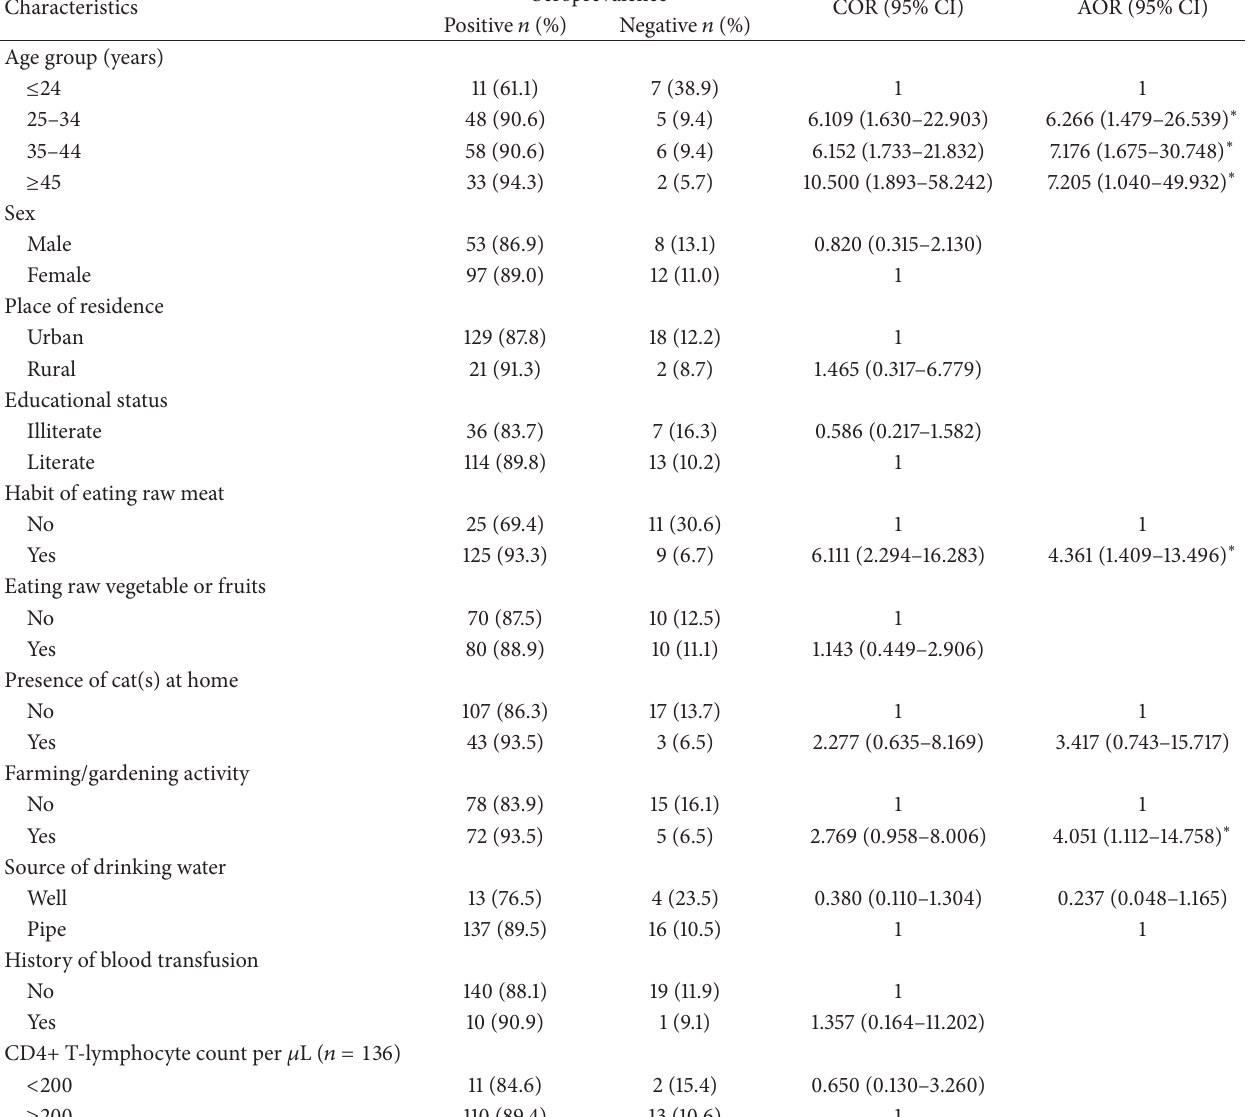
Table 2: Factors associated with T. gondii infection in the study participants, Arba Minch Hospital, 2013.